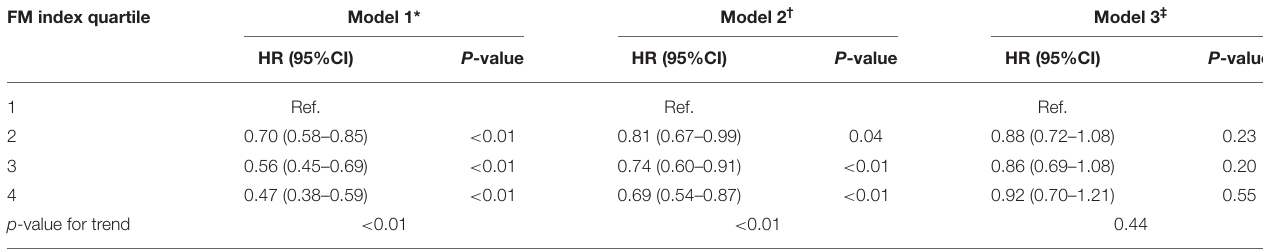
TABLE 3 | Hazard ratios (HR) for 1-year mortality of HF patients by fat mass (FM) index quartiles.